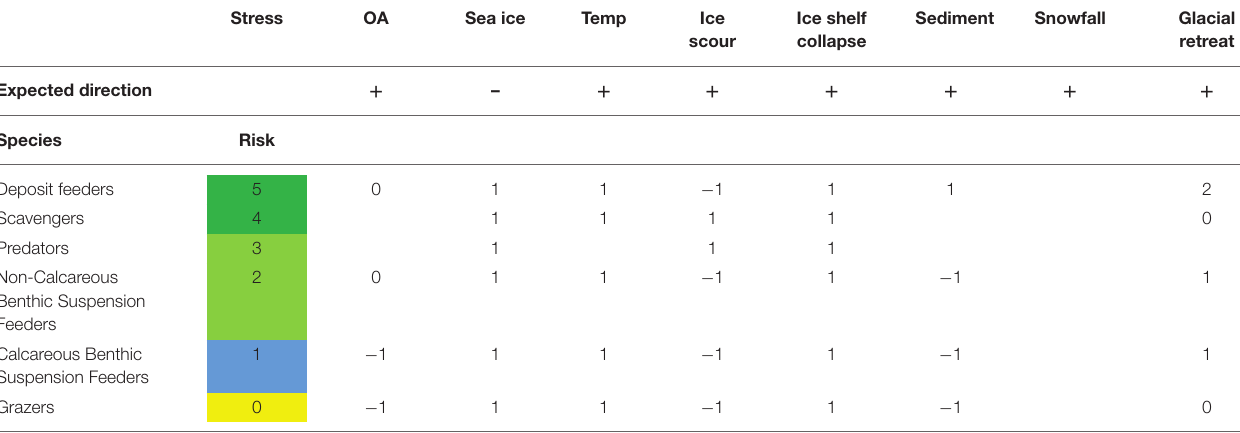
Stress OA Sea ice Temp Ice